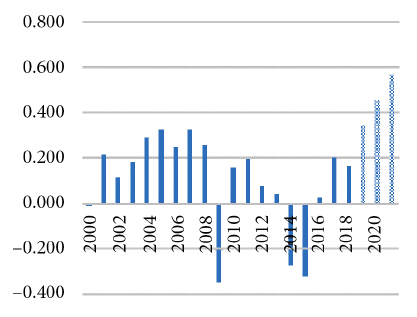
Figure 4. GDP per capita in Ukraine, 2000–2021, $ thousands (source: authors’